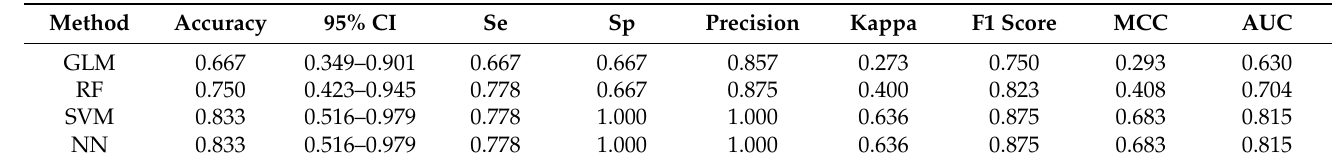
Table 3. Metrics (accuracy and 95% Confidence Interval (CI), sensitivity (Se), specificity (Sp), precision, Kappa value, F1 score, MCC and area under the receiver operating characteristic curve (AUC)) to compare methods performance on test set. Prediction models were developed using four different ML methods: GLM, RF, SVM and NN.